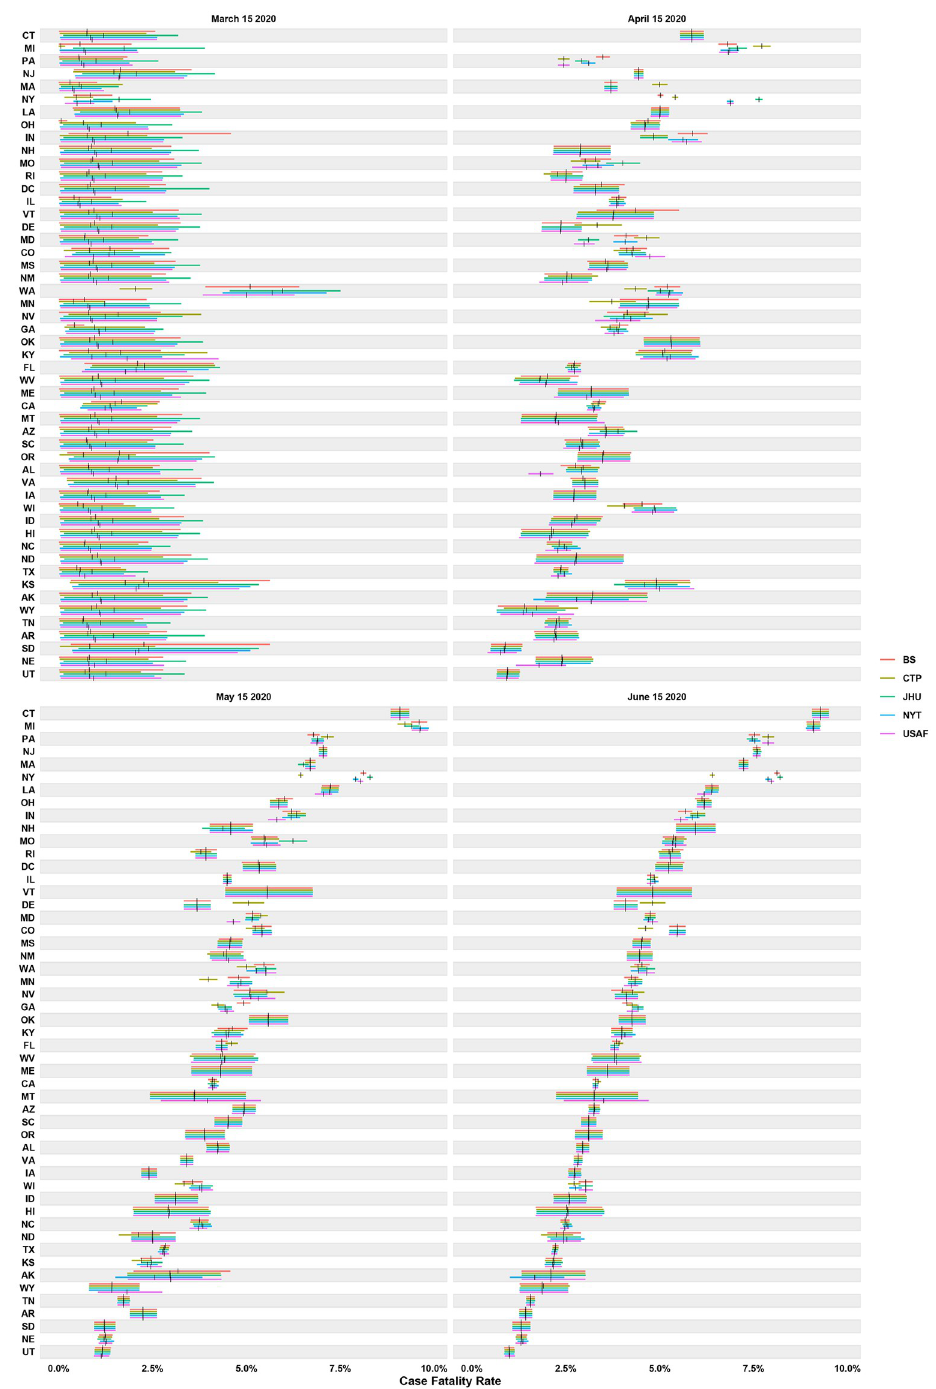
Fig 4. Time-progression of case fatality rate across states and sources. The horizontal bars represent the 90% equal- tail credible intervals, with the vertical black bars indicating the posterior means.